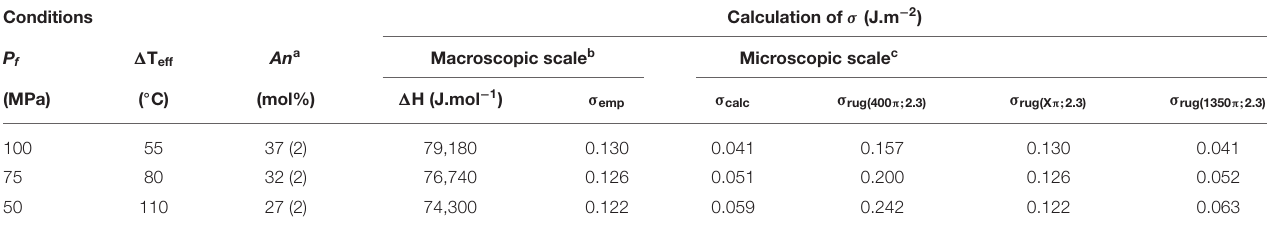
TABLE 4 | Determination of the interfacial energy ( σ ). Conditions